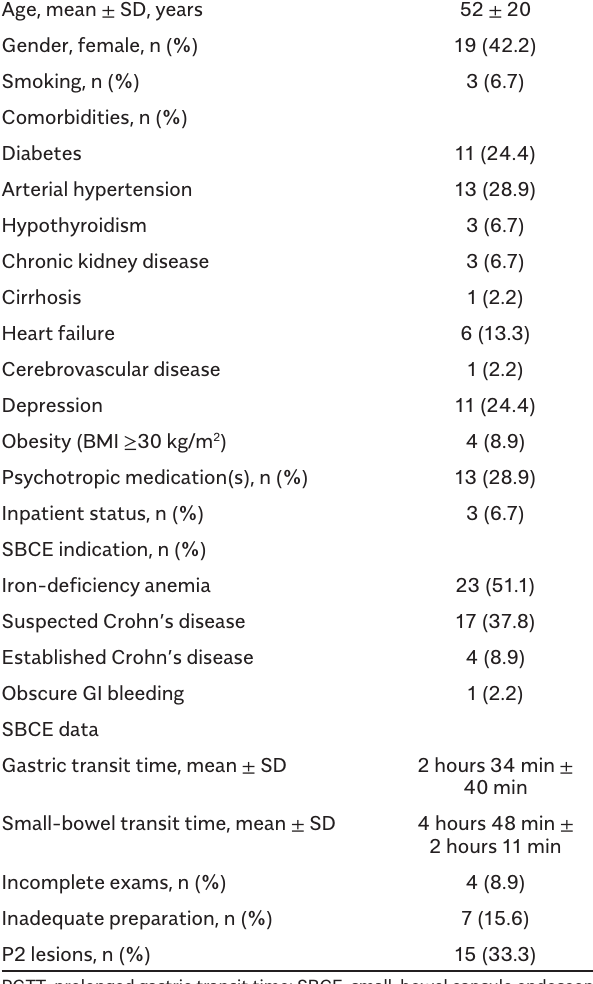
Table 2. Univariate Analysis Comparing Characteristics of Patients with PGTT with